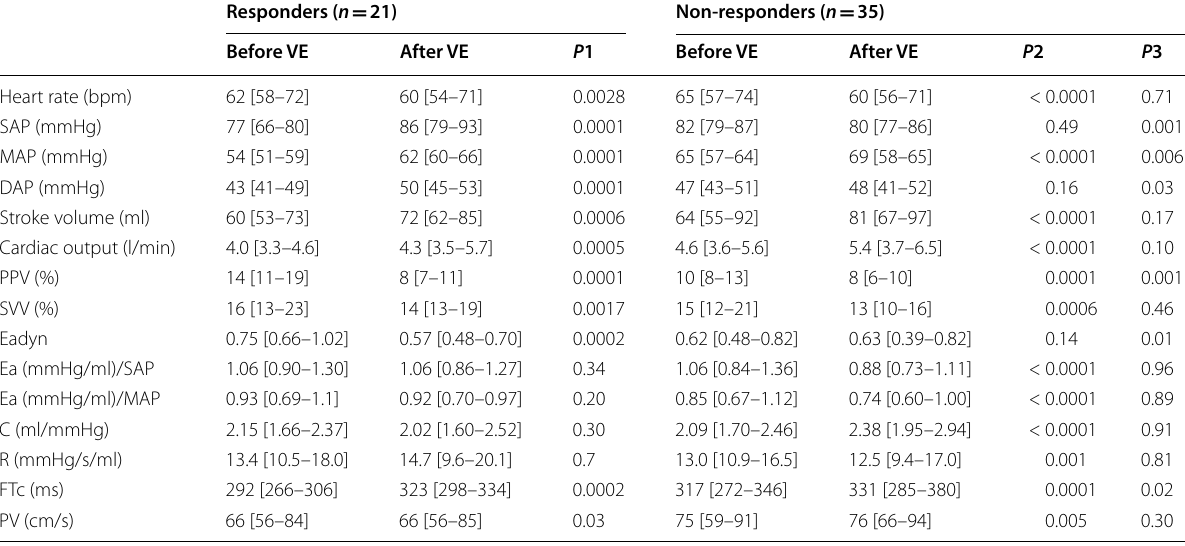
Table 5 Hemodynamic variables before and after volume expansion in responder and non-responder patients